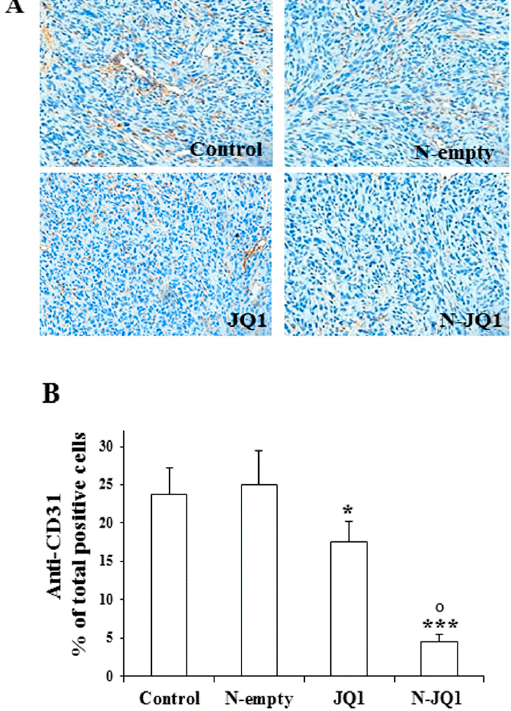
Figure 7. Immunohistochemical analysis of CD31 expression. ( A ) Representative images of immunostaining for CD31 in tumors of the four groups of animals treated as described in Methods (200× magnification). ( B ) The percentage of total positive cells for CD31 tumors are shown in bar graphs. JQ1, JQ1 (20 mg/kg) diluted in PBS + 5% PEG 400 + 5% TWEEN; N-JQ1, nanoparticles containing JQ1 20 mg/Kg; N-empty, unloaded nanoparticles; Control, untreated mice. Values are expressed as means ± SD. * p < 0.05, *** p < 0.001 vs. control; ° p < 0.05 vs. JQ1.